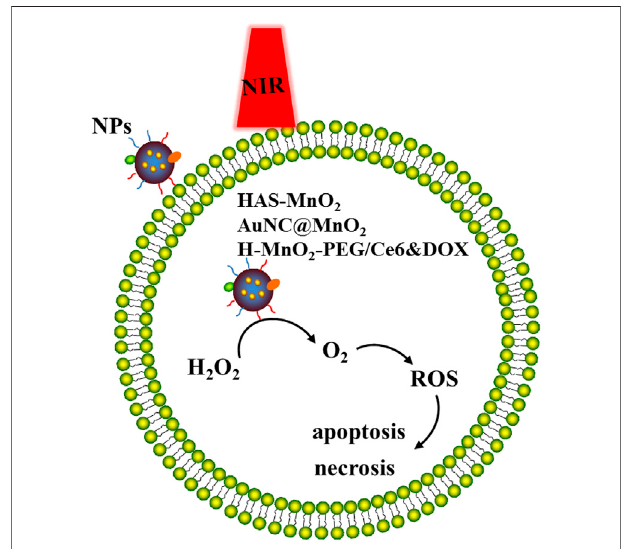
FIGURE4| NPsbased PDTimmunotherapy. Inthe presence ofspeci fi c wavelength excitation light, designed nanoparticles like HAS-MnO 2 , AuNC@ MnO 2 and H-MnO 2- PEG/Ce6&DOX transport oxygen into tumor or in situ generationofO 2 insidethetumor from endogenous H 2 O 2 withcatalysts, which improves tumor oxygenation level and changes tumor microenvironment, increases ROS levels, leading to tumor cell apoptosis and